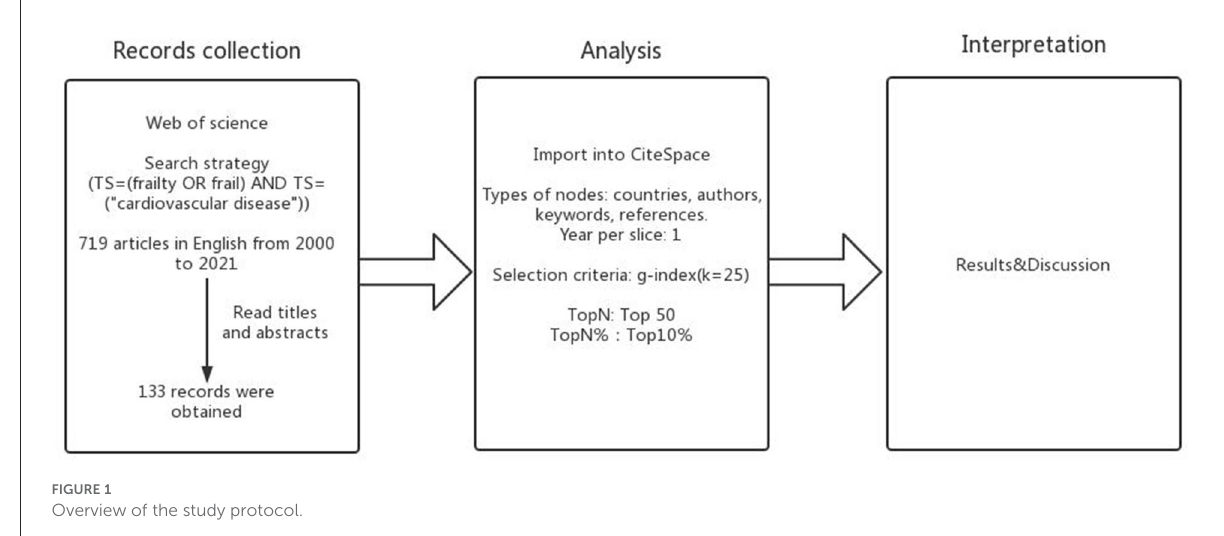
FIGURE1 Overview of the study protocol.